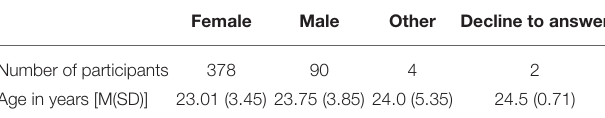
TABLE 1 | Demographic characteristics of the study sample. Female